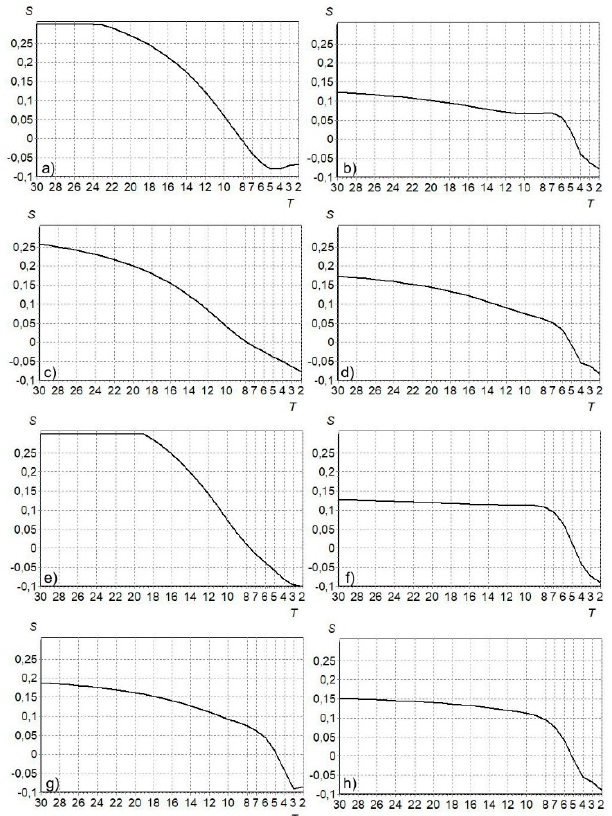
Figure 4. Mean annual spectra of water and air temperature for the Oder and Neman Rivers: ( a , b ) Odra (Brzeg)-Opole, ( c , d ) Odra (S ł ubice)- Gorzów Wlkp, ( e , f ) Niemen (Grodno)-Grodno, ( g , h ) Niemen (Smalininkai)-Raseiniai.